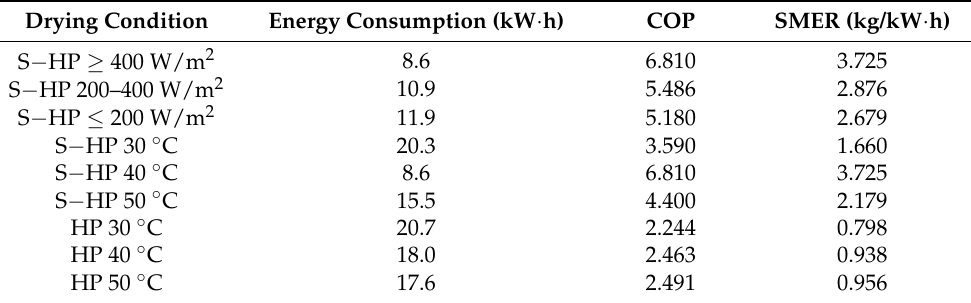
Table 8. System energy consumption, COP and SMER under different drying conditions.